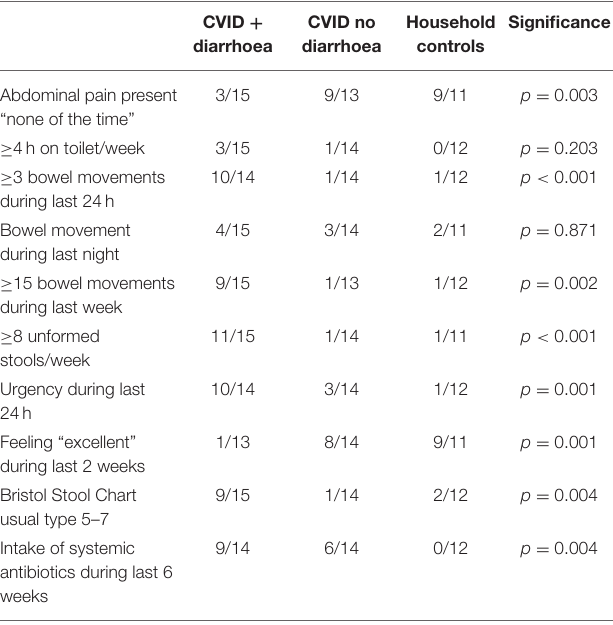
TABLE 2 | Abdominal pain, stool characteristics, and intake of antibiotics during the last 6 weeks. CVID +